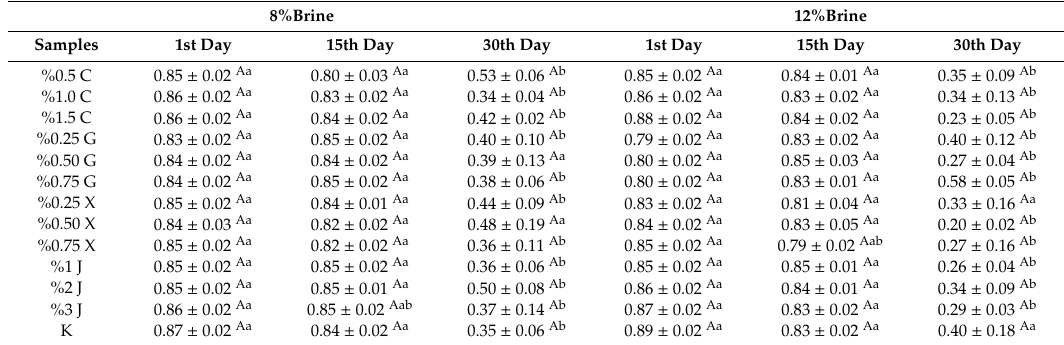
Table 7. Cohesiveness of cheese samples during storage.